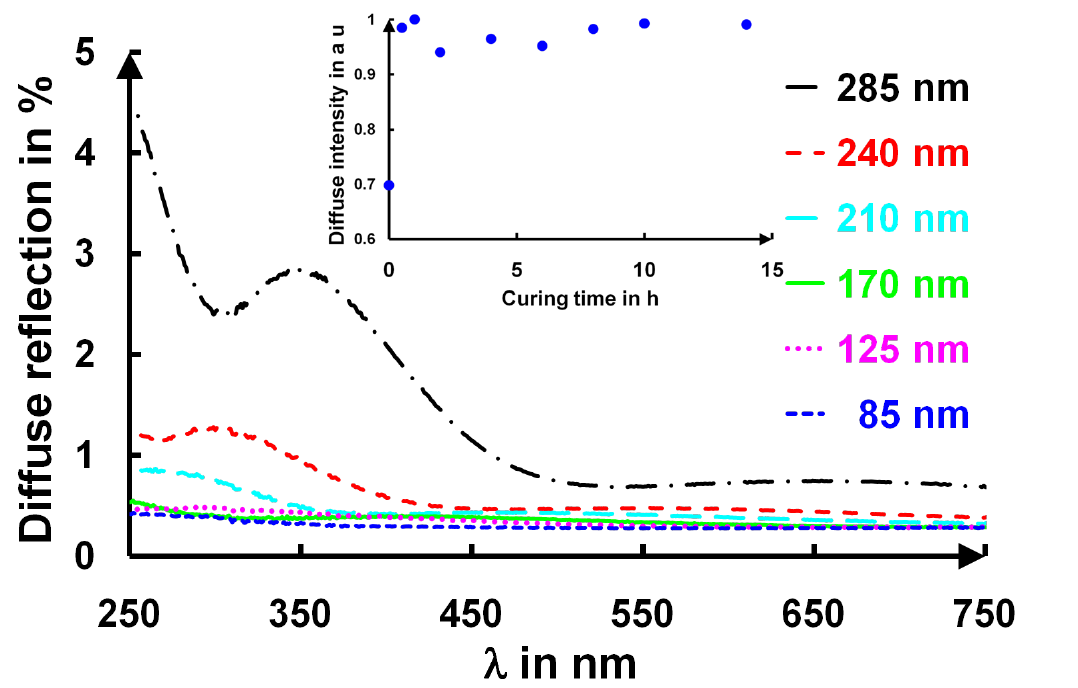
Figure 9. Diffuse reflection of silica coatings with different initial thicknesses after 17 h of curing and